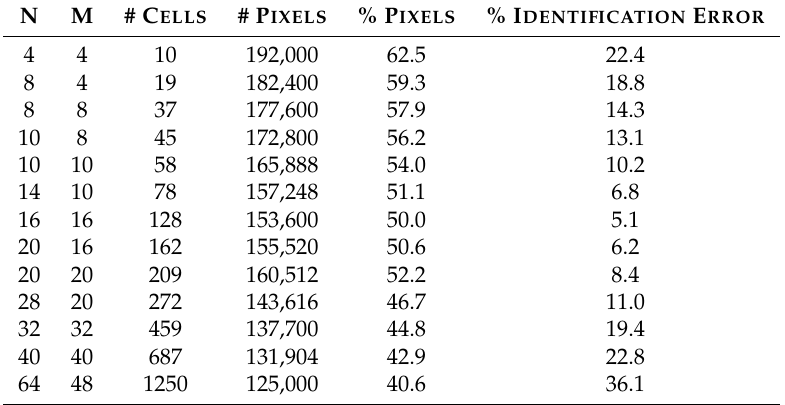
Table 1. Number of moving pixels (cells) detected as a function of the partitioning thresholds N and M .